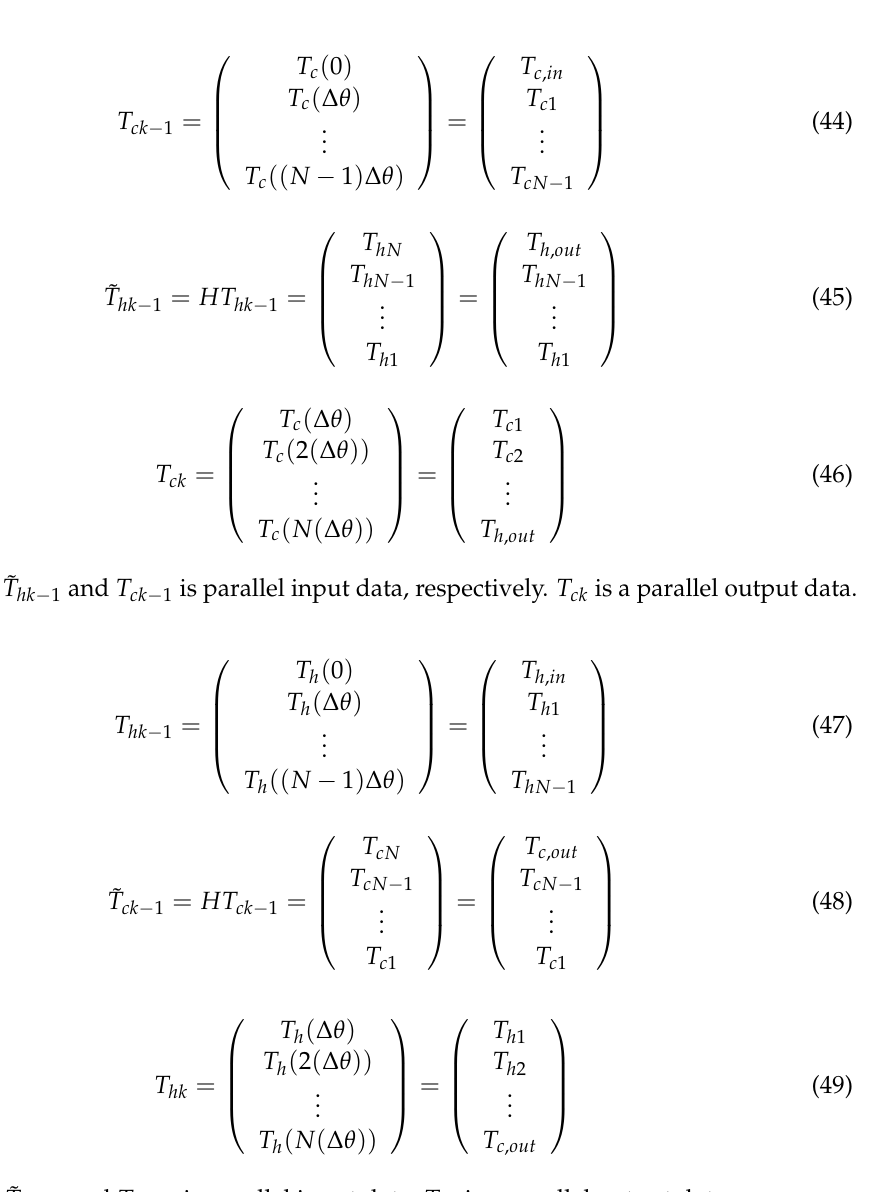
In Figure 6, ˜ T ck − 1 and T hk − 1 is parallel input data, T hk is a parallel output data. The thread blocks of proposed parallel model for the spiral-plate counter-flow